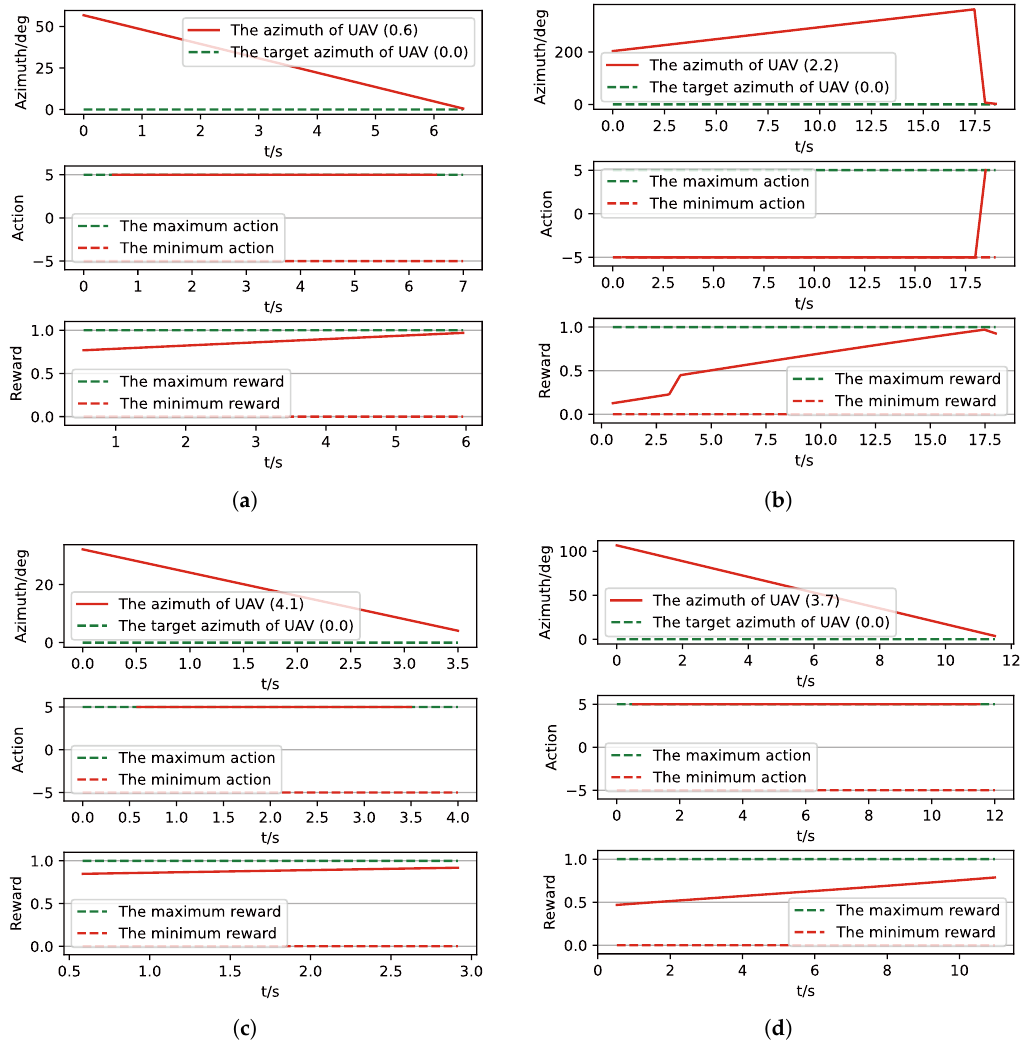
Figure 11. The parameters curve from MC experiments for the trained result of UER-DDPG. ( a ) The parameters curve of 1st experiment; ( b ) the parameters curve of 2nd experiment; ( c ) the parameters curve of 3rd experiment; ( d ) the parameters curve of 4th experiment.